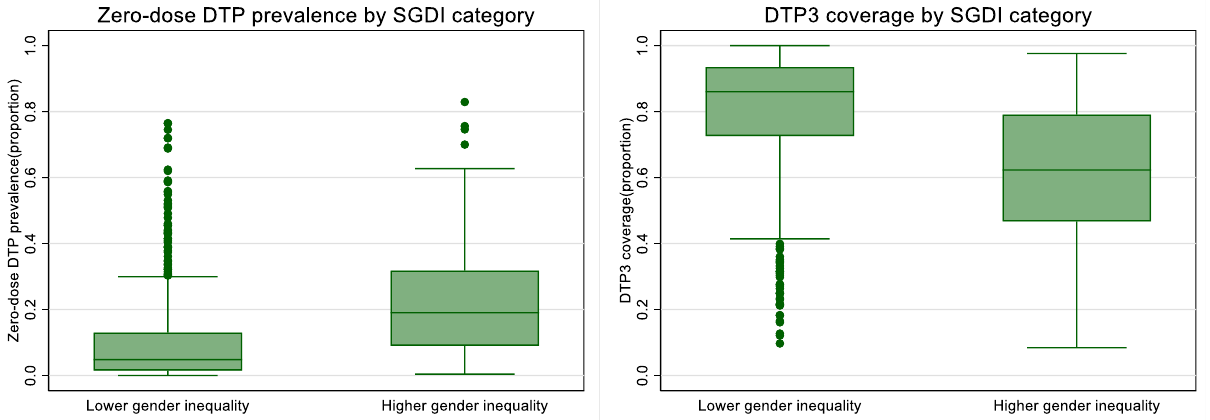
Figure 3. Prevalence of zero-dose DTP and DTP3 immunization coverage by SGDI category, most recent year of available data. Note that boxes show 25–75th percentile values, with 50th percentile (median) line inside box. Single dots are outlier values.